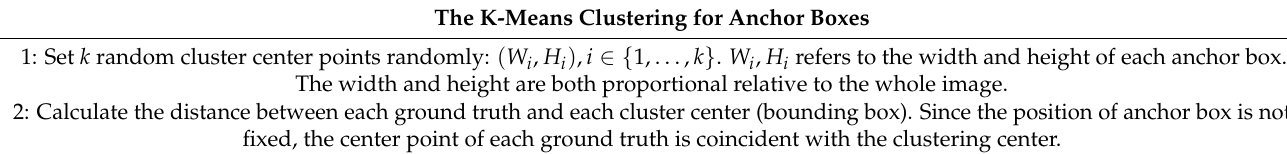
Table 2. Pseudo code of K-means for anchor boxes. The K-Means Clustering for Anchor Boxes